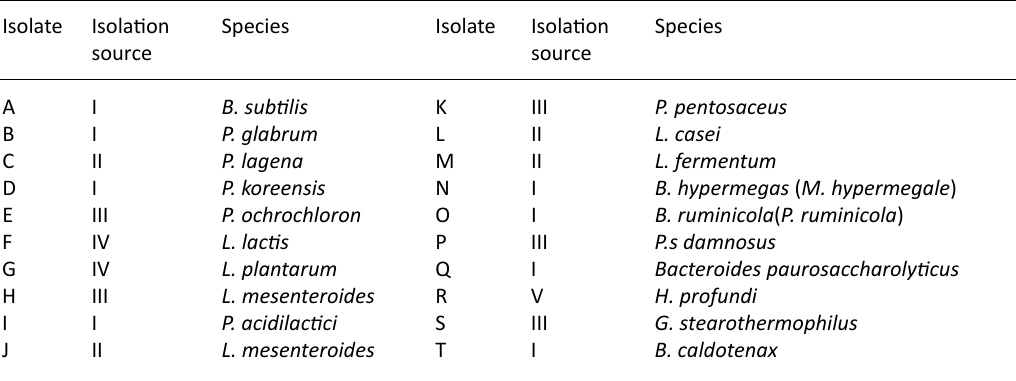
Table 1. Results of the identification of microorganisms depending on the isolation sources Isolate Isolation Species Isolate Isolation Species source